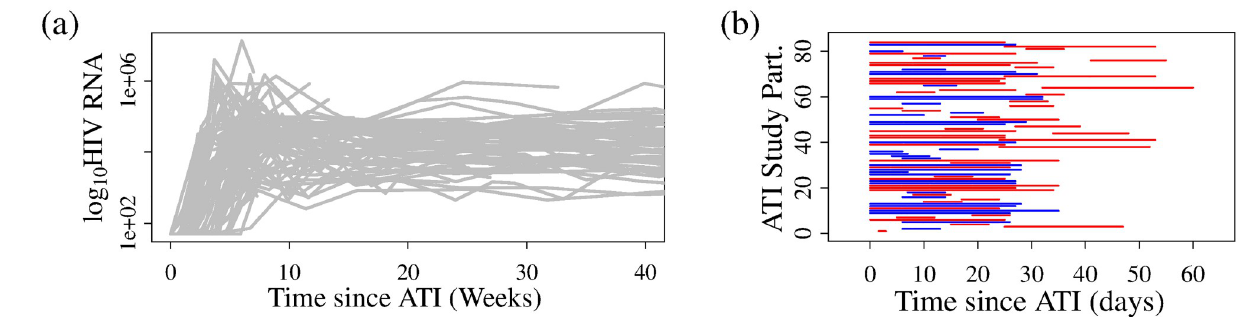
Fig 1. Participant viral loads following ATI. (a) Plasma HIV RNA levels following ATI; each corner represents a measurement, with lines used to connect the measurements from the same participant. (b) The times of last undetectable measurement and first detectable measurement shown as line segments spanning the detection window per ATI study participant, with color indicating whether the pre-ATI ART regimen included (red) or excluded (blue) NNRTIs.